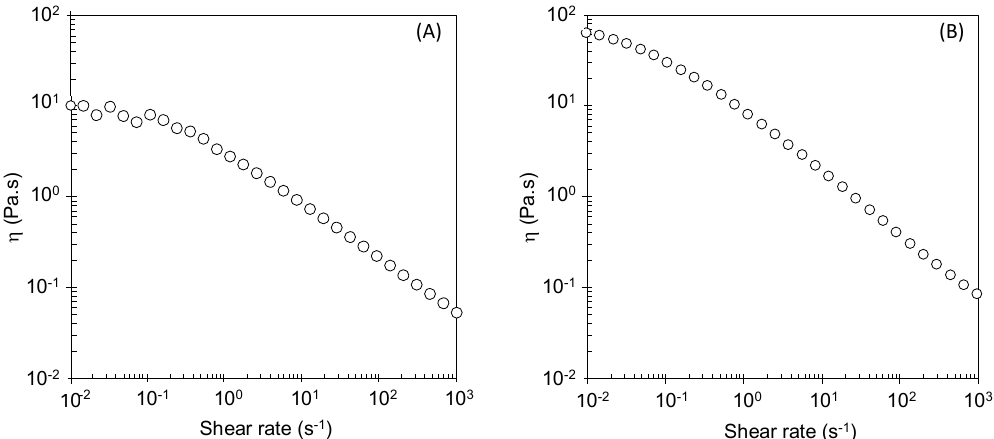
Figure 2. Flow curves of ( A ) B. thailandensis biosurfactant aqueous solution at a concentration of 10 g/L (at 25 °C) and ( B ) the sunflower oil emulsion stabilized with B. thailandensis biosurfactant (at 25 °C).